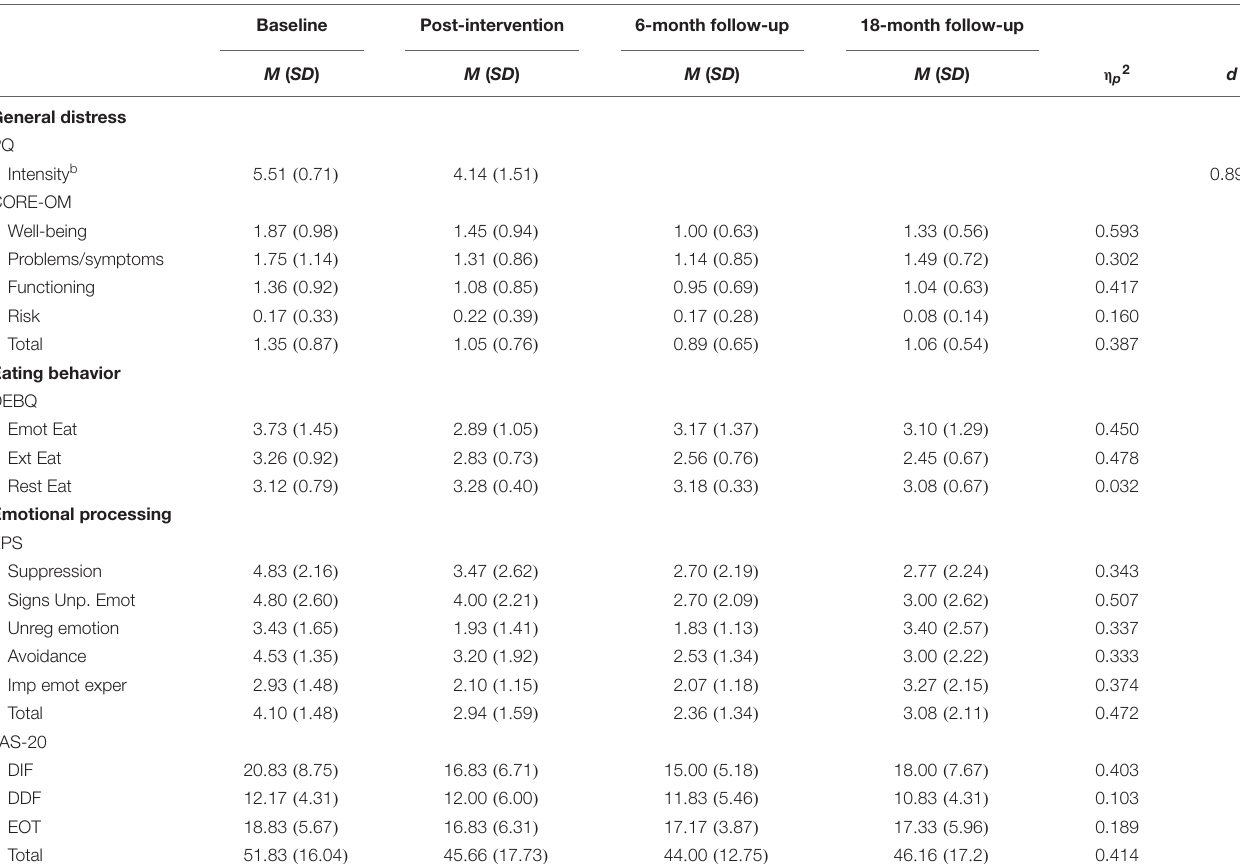
TABLE 1 | Change in outcome variables over the four assessment